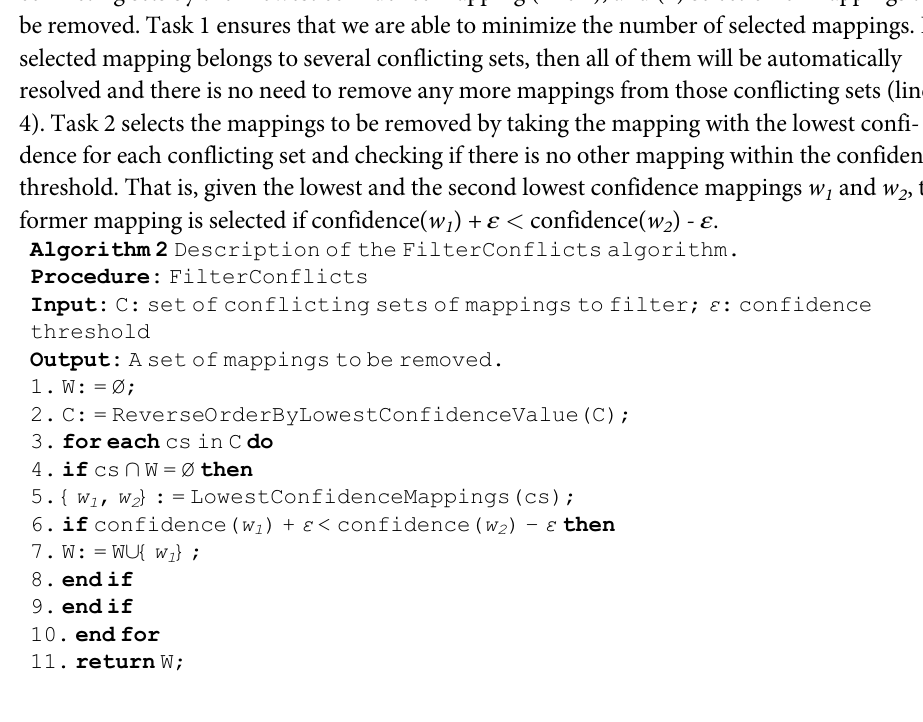
Algorithm 2 Description of the FilterConflicts